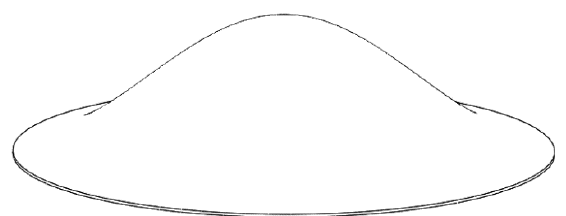
Figure 2. The contour curve of the bionic structure.